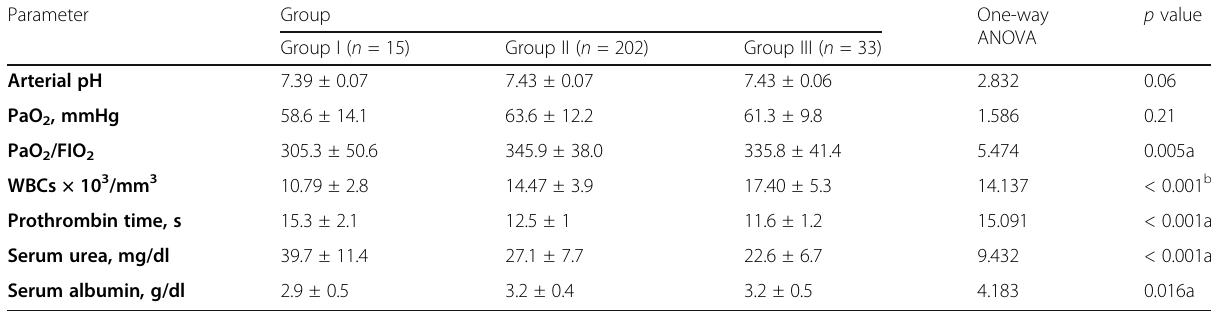
Table 2 ABG s and laboratory parameters on admission among all studied groups Parameter